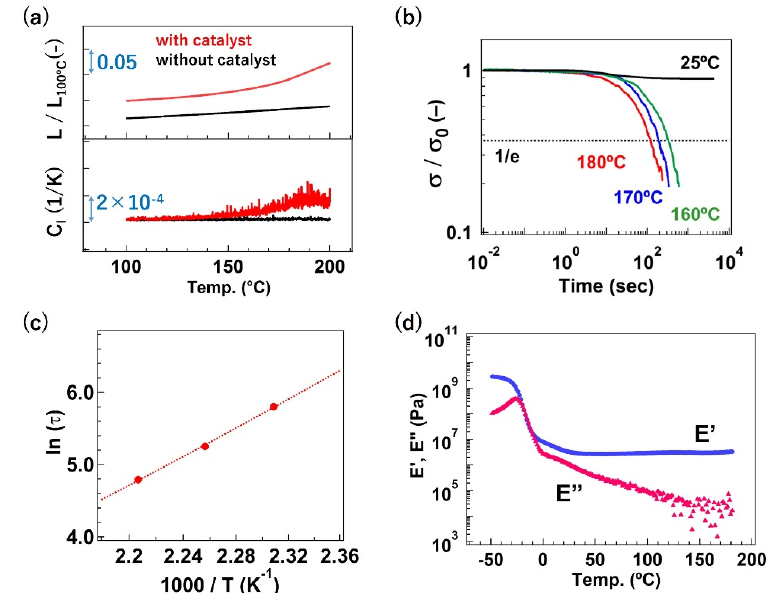
Figure 4. Molecular design of amorphous low T g polyester-based vitrimers reported by M. Hayashi et al. from ref. [26]. Reproduced/adapted by permission of The Royal Society of Chemistry.